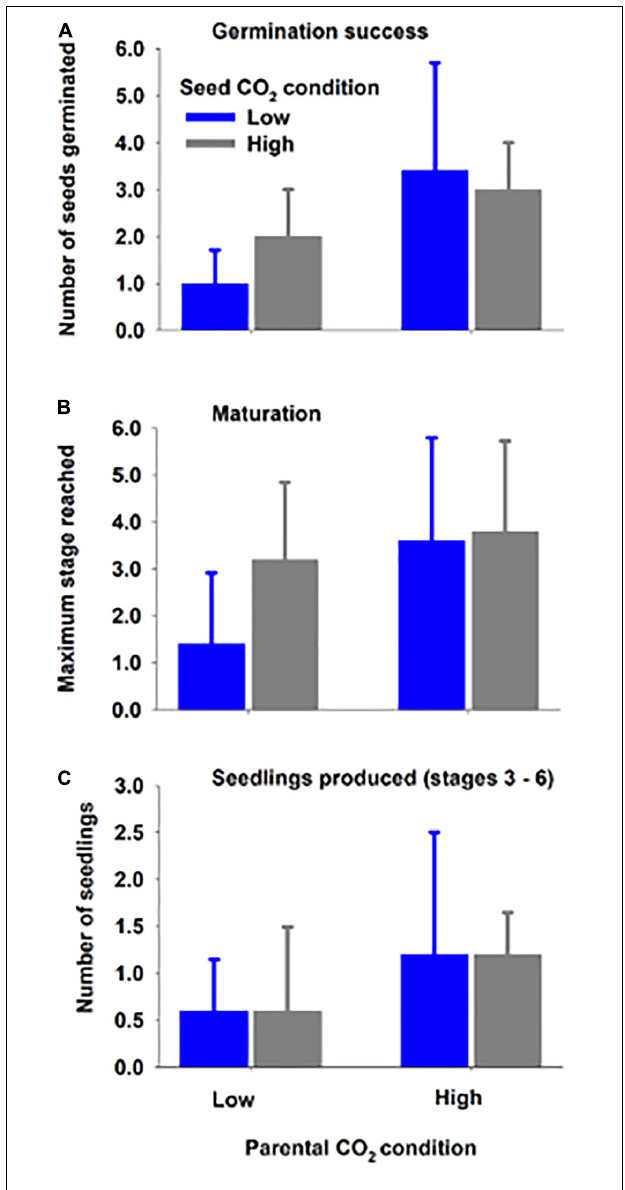
FIGURE 4 | Mean ( ± SD) germination success (A) , seedling maturation (B) , and seedlings produced (C) at the end of study for seeds developed (parent) under high or low CO 2 condition and placed (seed) within water with high or low CO 2 condition for 32 days (Experiment 2). Results of two-way ANOVAs ( Table 4 ) indicate that the high parental CO 2 condition resulted in greater germination